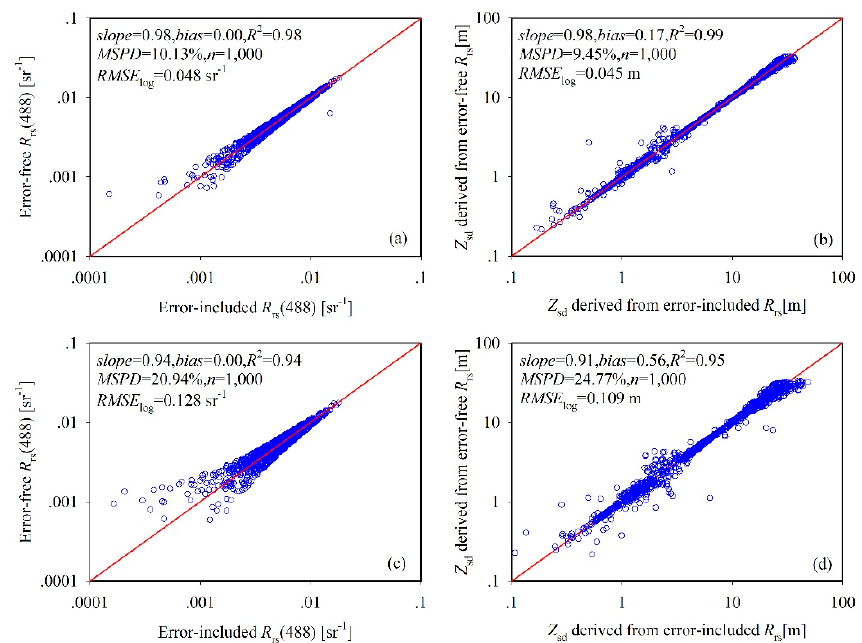
Figure 5. The sensitivity of CSSD model to residual error in ( a , b ) test 1 and ( c , d ) test 2. ( a , c ) were the comparison of error-free versus error-included R rs (488) in two tests; ( b , d ) were the comparison of Z sd values derived from the error-free versus error-included R rs data in two tests.